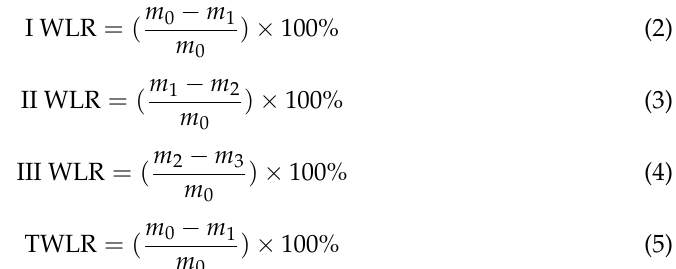
12 of 19 Figure 8. Histogram of weight-loss rate in different reduction stages of pellet samples with different basicities . 3.3. Analysis of SEM and Its Energy-Dispersive Spectrum In order to better explore the microstructure changes in pellets during the reduction process, combined with the reduction expansion laws of pellets with different basicities obtained in Table 4, the basicity is divided into three gradients: low basicity (0.4–0.6), me-